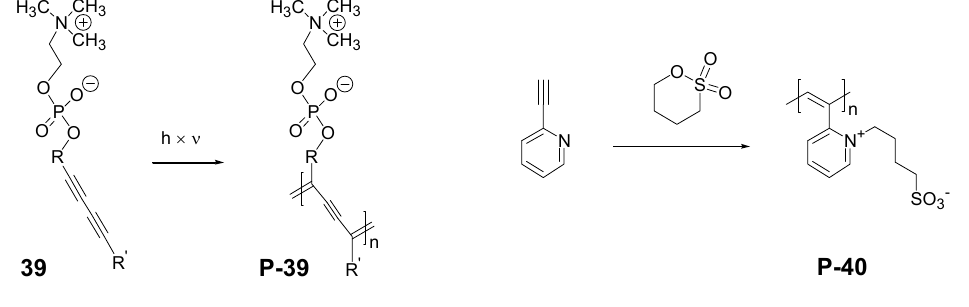
conjugated diynes ( left ) [20,22,131,370], and via alkylation induced polymerization